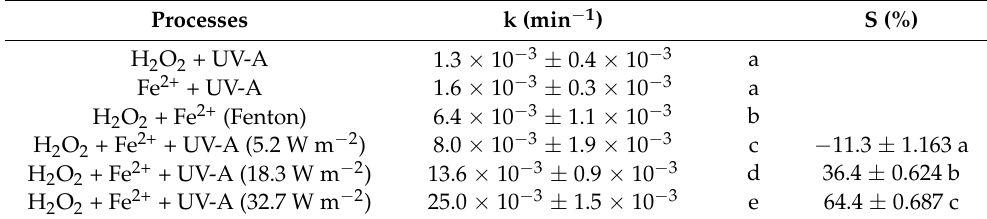
Figure 9. Progress of TOC percentage removal at different H 2 O 2 concentrations (9.7–77.6 mM) in the UV-A-Fenton process. Experimental conditions: [Fe 2+ ] = 1.0 mM, pH = 3.0, agitation = 350 rpm, T = 25 °C, radiation = UV-A, I UV = 32.7 Wm − 2 , and t = 90 min. Blank non-catalytic experiments (UV-A/H 2 O 2 and UV-A without H 2 O 2 ) are also represented as a reference. Table 3. Synergistic effect between photo-Fenton